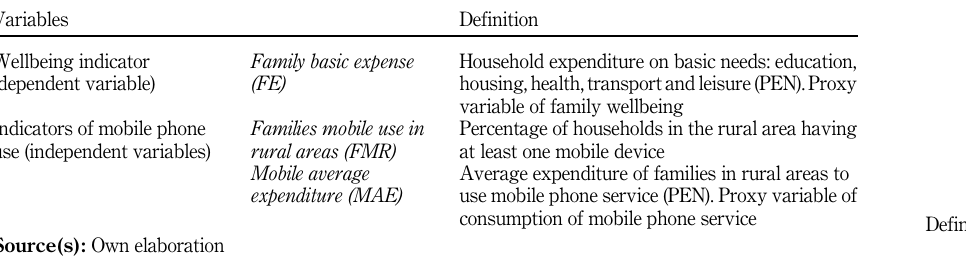
Table 1. Definition of the